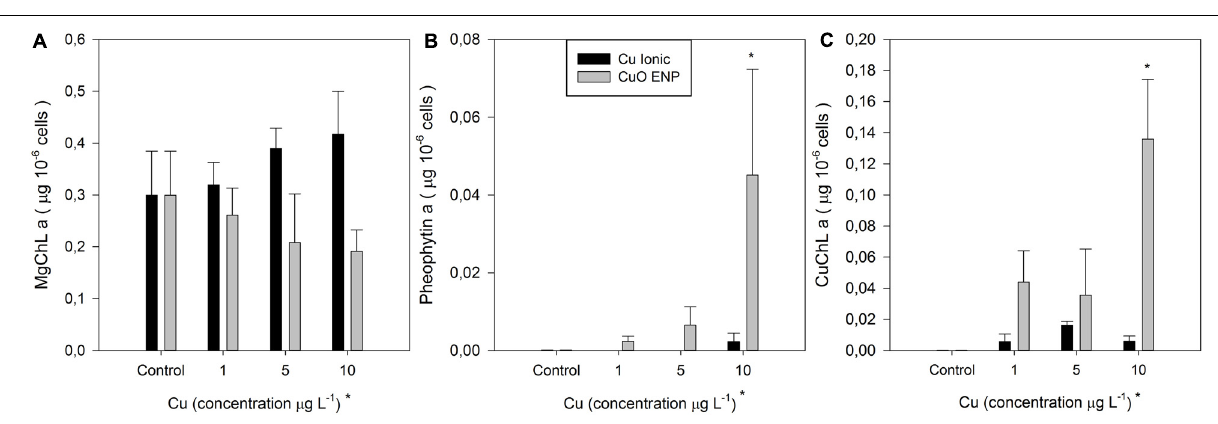
FIGURE 6 | (A) Chlorophyll a , (B) Pheophytin a , and (C) Cu-chlorophyll a concentration ( µ g 10 - 6 cells) in P. tricornutum after 3 days of exposure to increasing ionic Cu (black bars) and CuO ENP (gray bars) concentrations (average ± standard deviation, N = 3, *above bars indicate significant differences compared with the control at p < 0.05, whilst *below x -axis indicate significant differences between ionic Cu and CuO ENP at the same